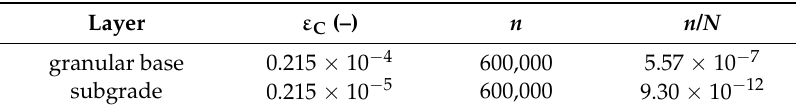
Table 11. Rutting verification-block pavement.